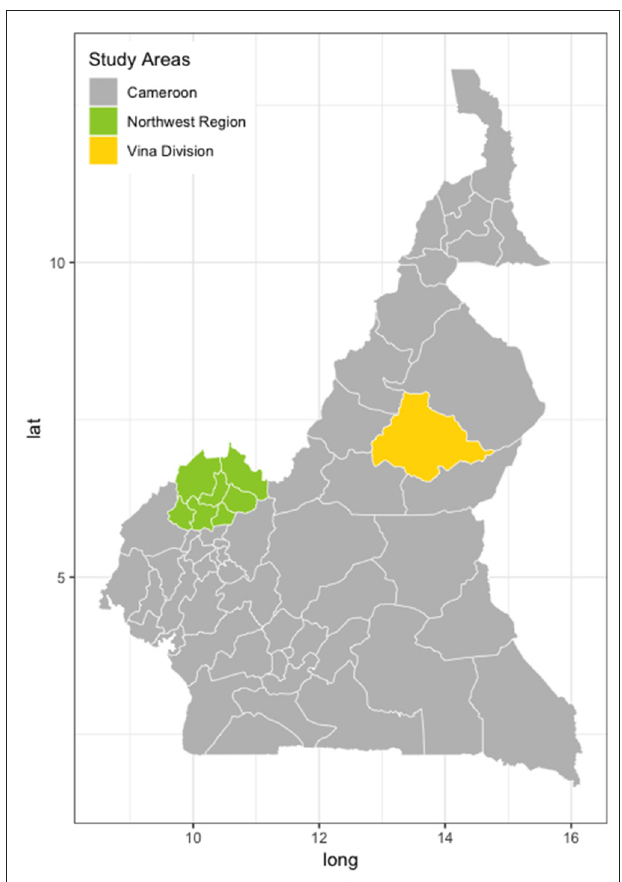
FIGURE 1 | Map of Cameroon showing the two study locations. North West Region (green) and the Vina Division of the Adamawa Region (yellow) (